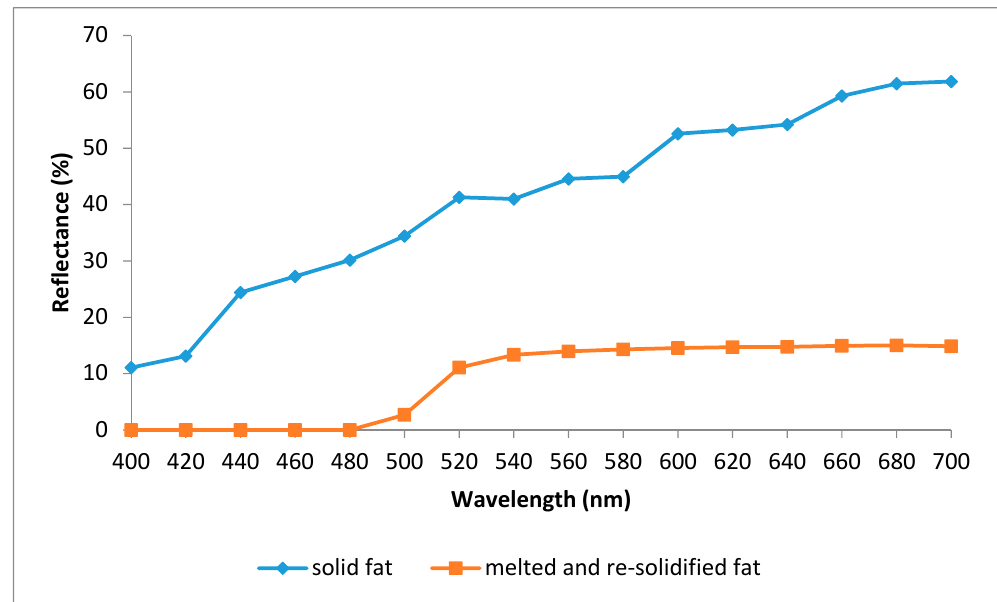
Figure 2. Reflectance spectra (400–700 nm) of the chicken fat by-products (solid fat and, melted and re-solidified fat).